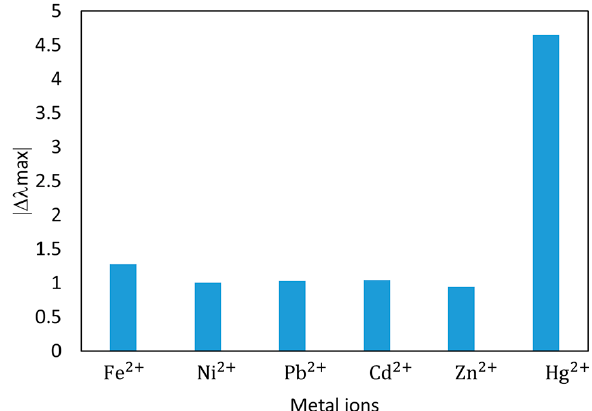
Figure 10. Selectivity analysis against the most common heavy ions. The measurements were carried out using the same sampling preparation process, and with the same concentration (20 ppb).